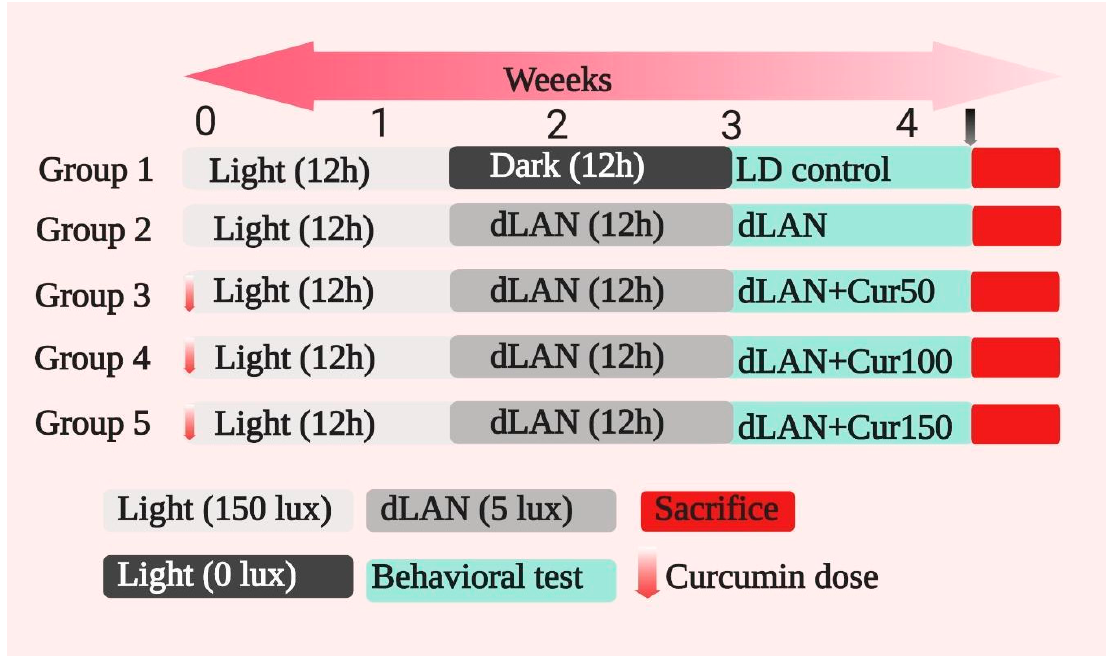
Figure 2. Details of experiment design. Total 30 Swiss Albino mice (age = four weeks, weight = 25–30 g) were used in the present study. The mice were divided into following groups and treated with different concentrations of curcumin (50, 100, and 150 mg/kg). The details of each group are as follows: